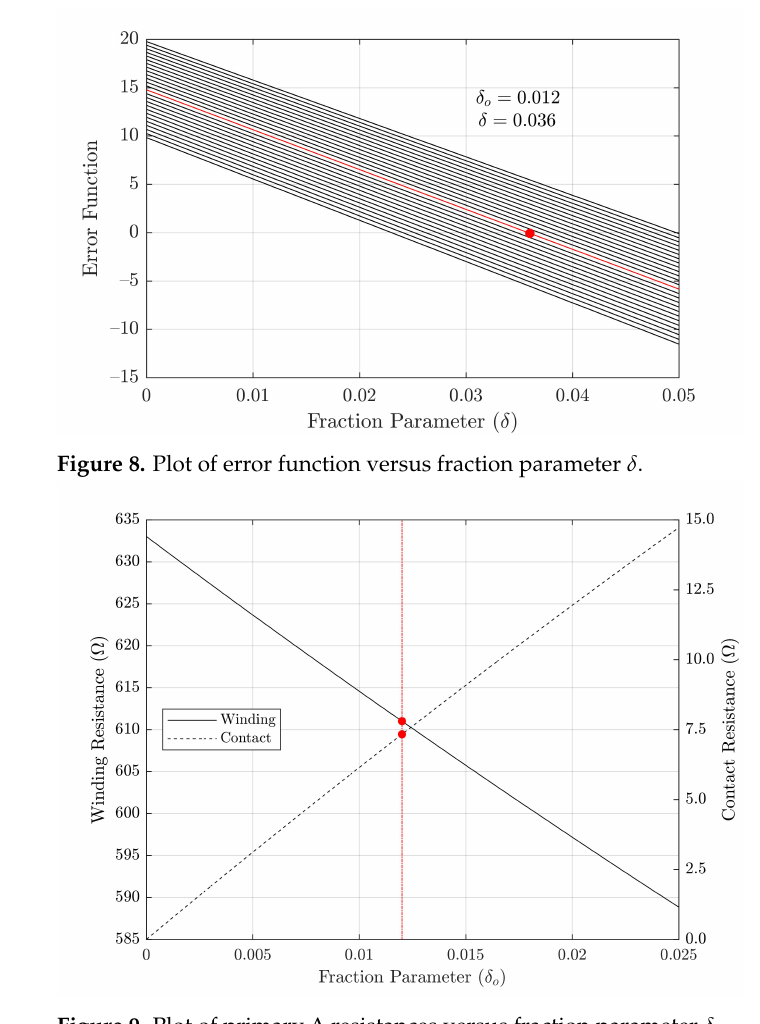
Figure 9. Plot of primary ∆ resistances versus fraction parameter δ o